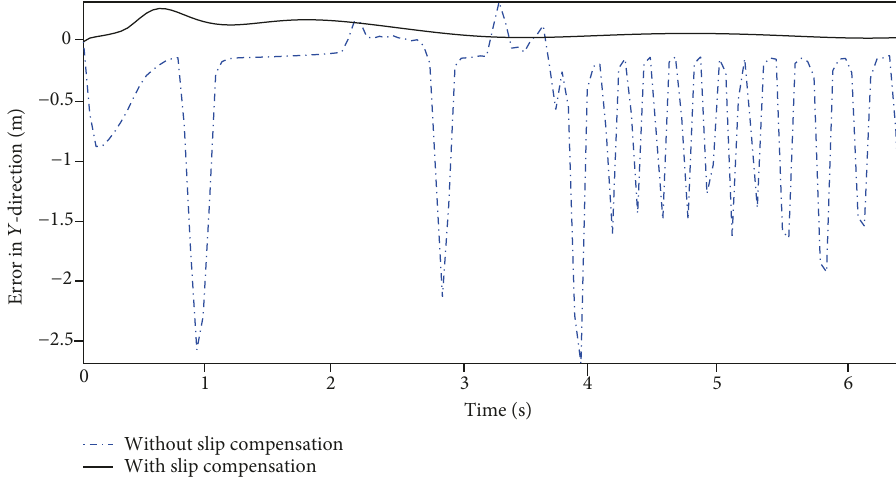
Figure 6: The comparison of error in the Y -direction with active slip